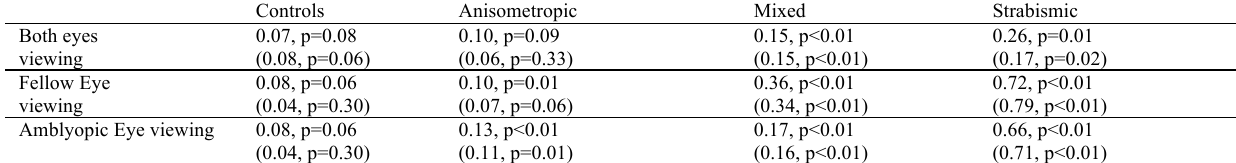
Table 4: Correlation between inter-saccadic drift velocity/slow phase velocity and fixational saccade/quick phase nys- tagmus amplitude respectively by type Controls Anisometropic Mixed Strabismic Both eyes viewing Fellow Eye viewing Amblyopic Eye viewing Both eyes viewing: top row: fellow eye, bottom row with parenthesis = amblyopic eye Fellow and Amblyopic eye viewing: top row: viewing eye, bottom row: non-viewing eye First value in each cell is the rho and second is the p value obtained by performing Spearman